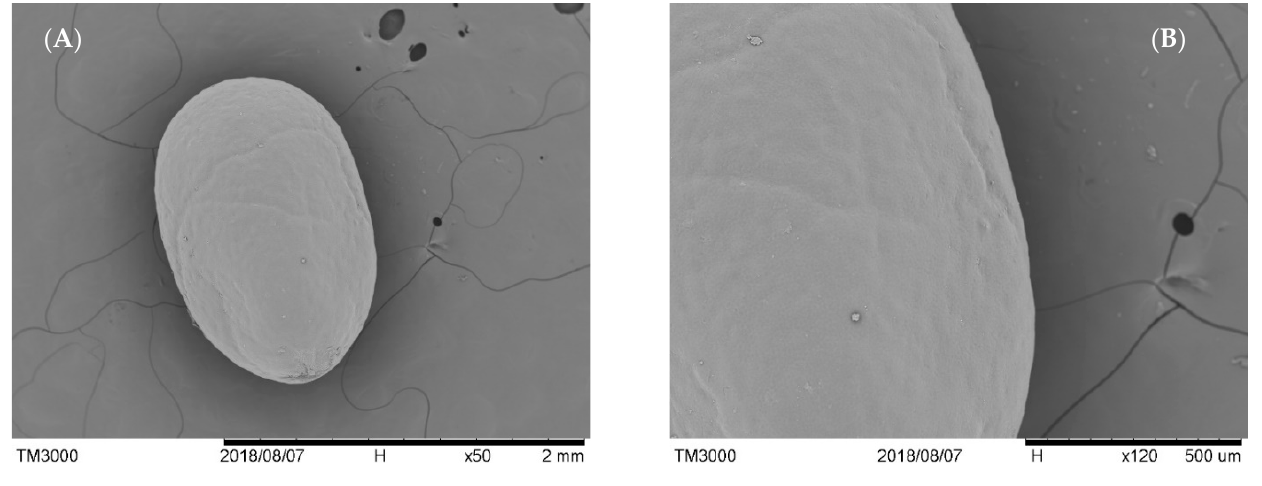
Figure 1. Scanning electron microscopy (SEM) images ( × 120) of raw chia seed: ( A ) Lateral view ( × 50); ( B ) pericarp surface.